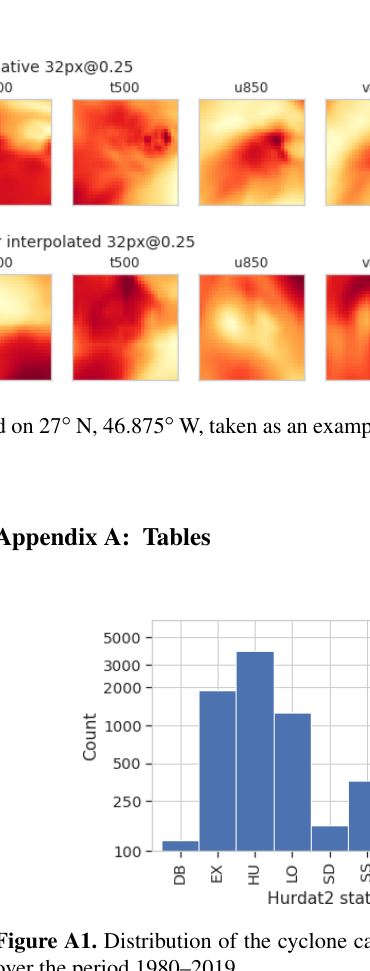
Figure 10. Channels of the image on 5 August 1990, 00:00UTC, centered on 38 ◦ N, 30.625 ◦ W, taken as an example of a wrongly classified image as a cyclone (false positive). Data are standardized.